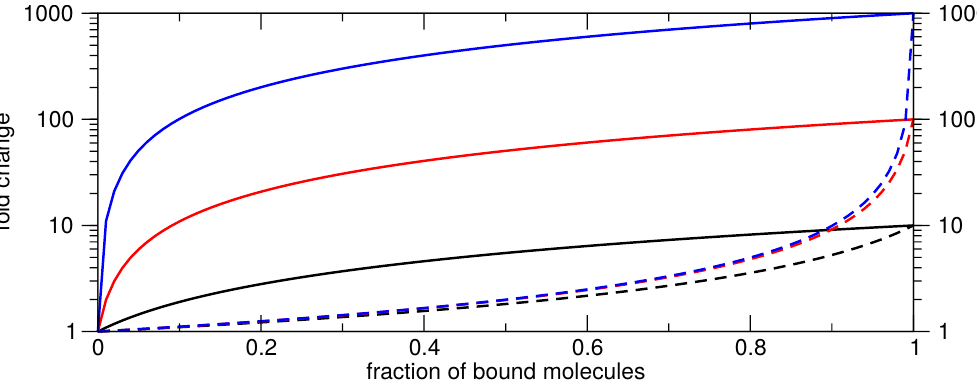
Figure 4. Achievable fold change for activating (straight) and repressing (dashed) switches depending on the fraction of bound molecules. The plots demonstrate that achieving the same fold change requires to bind a much higher fraction of molecules in represessing systems compared to activating systems. Different colors correspond to varying ratios of the assumed expression values in the OFF and the ON state (1:10, 1:100, 1:1000 are black, red and blue respectively). This ratio is also determined by the start at (0,1) and the end value at (1,y max ) of each curve. Note that the y -axis is shown in log